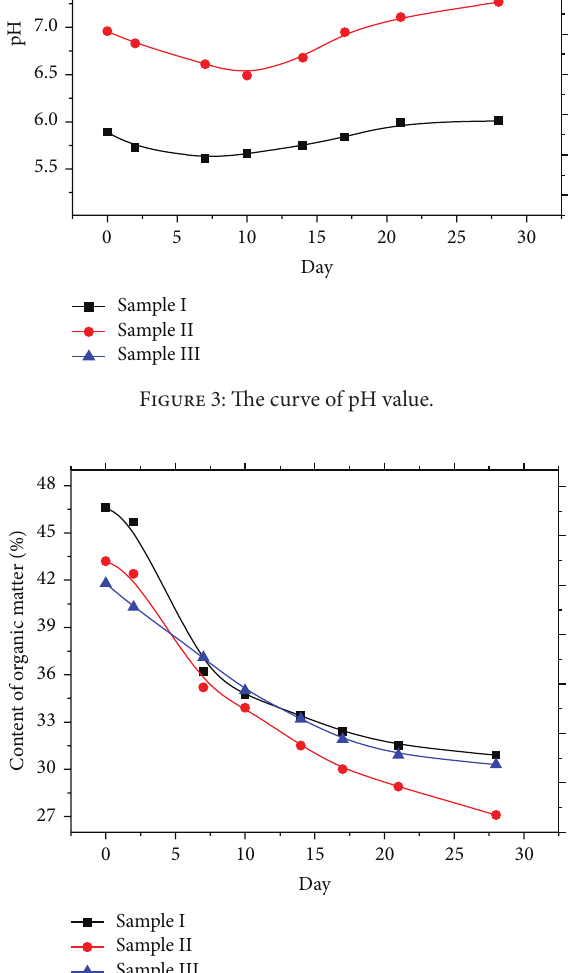
Figure 4: The curve of organic